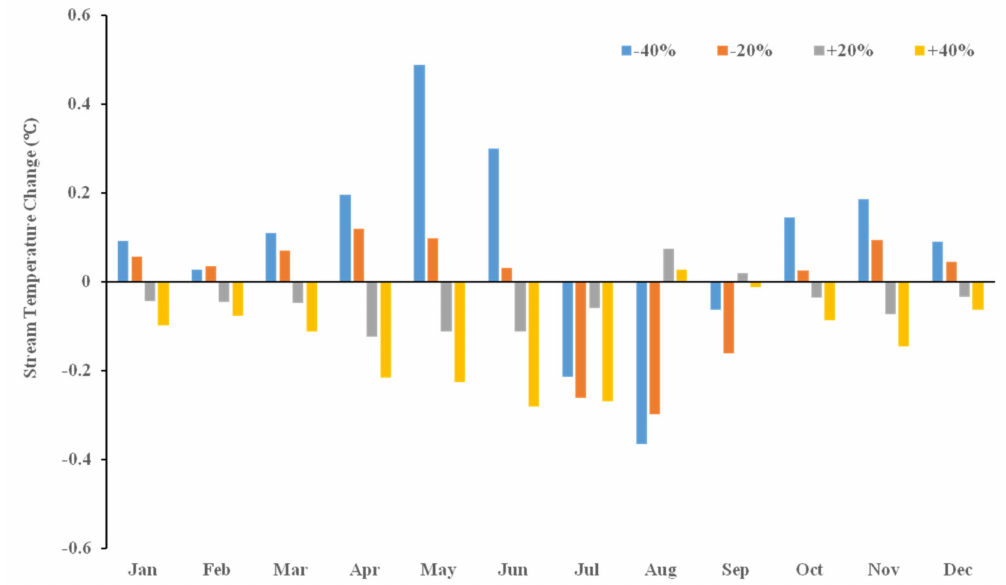
Figure 7. Stream temperature sensitivity to precipitation change in the